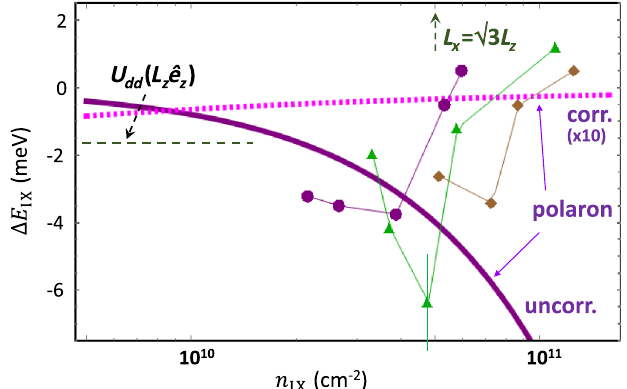
FIG. 6. Interaction-induced energy shifts Δ E of IX H excitons IX induced by a remote IX L cloud with different densities n . IX Results are shown for probing IX H densities estimated as 8 × 10 10 (dots), 9 × 10 10 (triangles), and 9 . 7 × 10 10 cm − 2 (dia- 5 × 10 10 cm − 2 monds). The error bar shown only for n IX ¼ applies for all data points. The vertical dashed arrow marks ffiffiffi p 3 L L the density for which L x ¼ z , where x is the average inter- IX L distance. The thick dotted and solid lines display the prediction of the polaron model (cf. Fig. 7) in the limit of fully correlated [corr.; cf. Eq. (4)] and uncorrelated [uncorr.; cf. Eq. (5)] IX gases, respectively. The horizontal dashed line marks the minimum of the inter-DQW interaction potential U dd ð L z ˆ e z þ ˆ e r Þ given by Eq. (1). k k